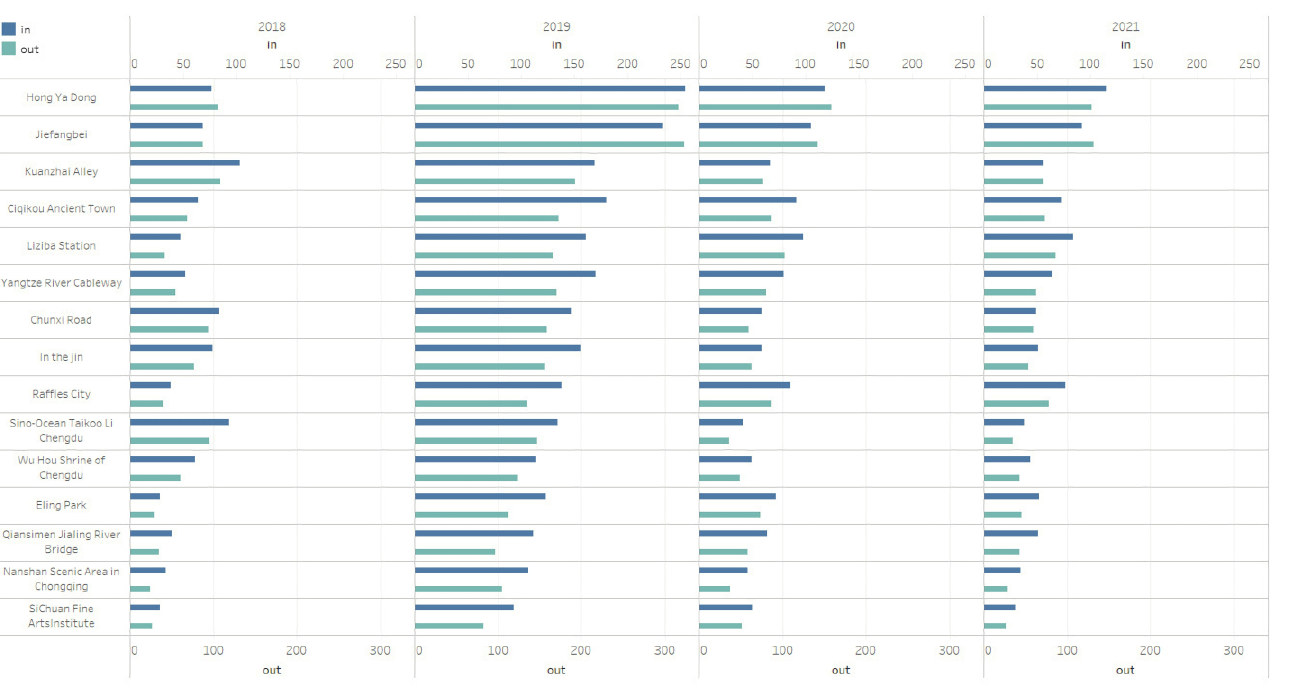
Figure 5. Degree centrality value of tourist attractions in the Chengdu–Chongqing Economic Circle in 2018 – 2021.